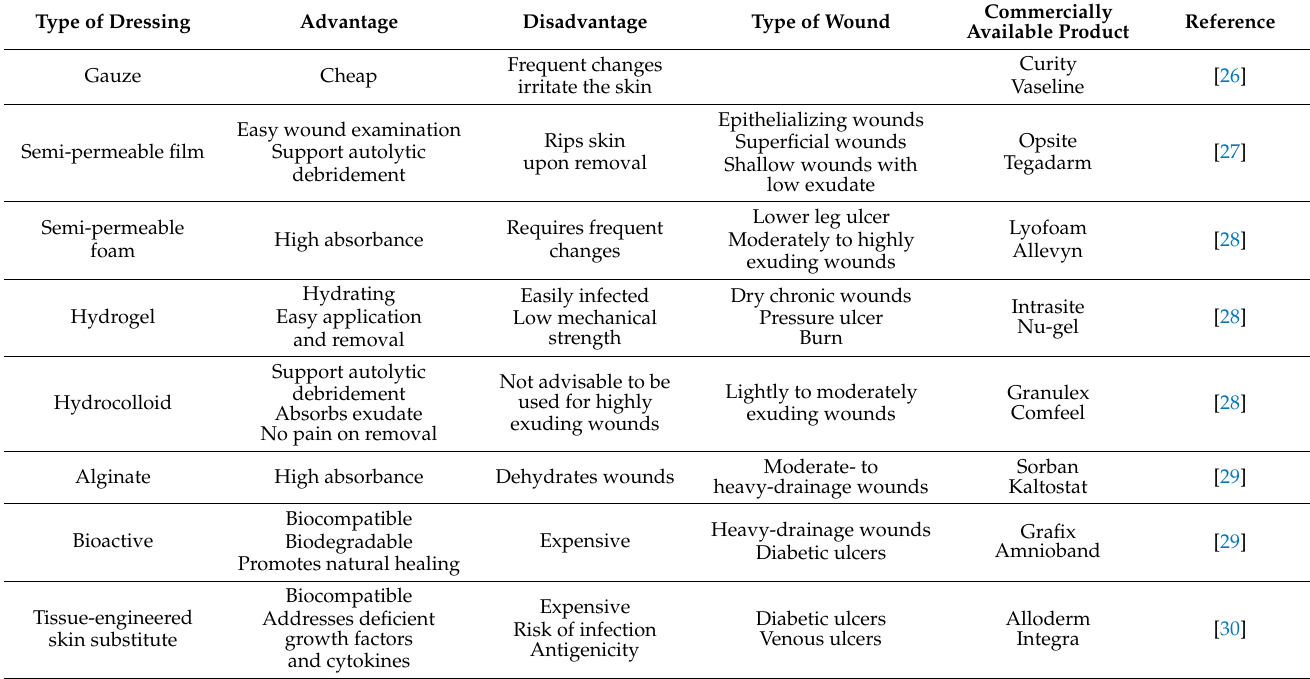
Table 1. Characteristics and indications of wound dressings that are widely used in the